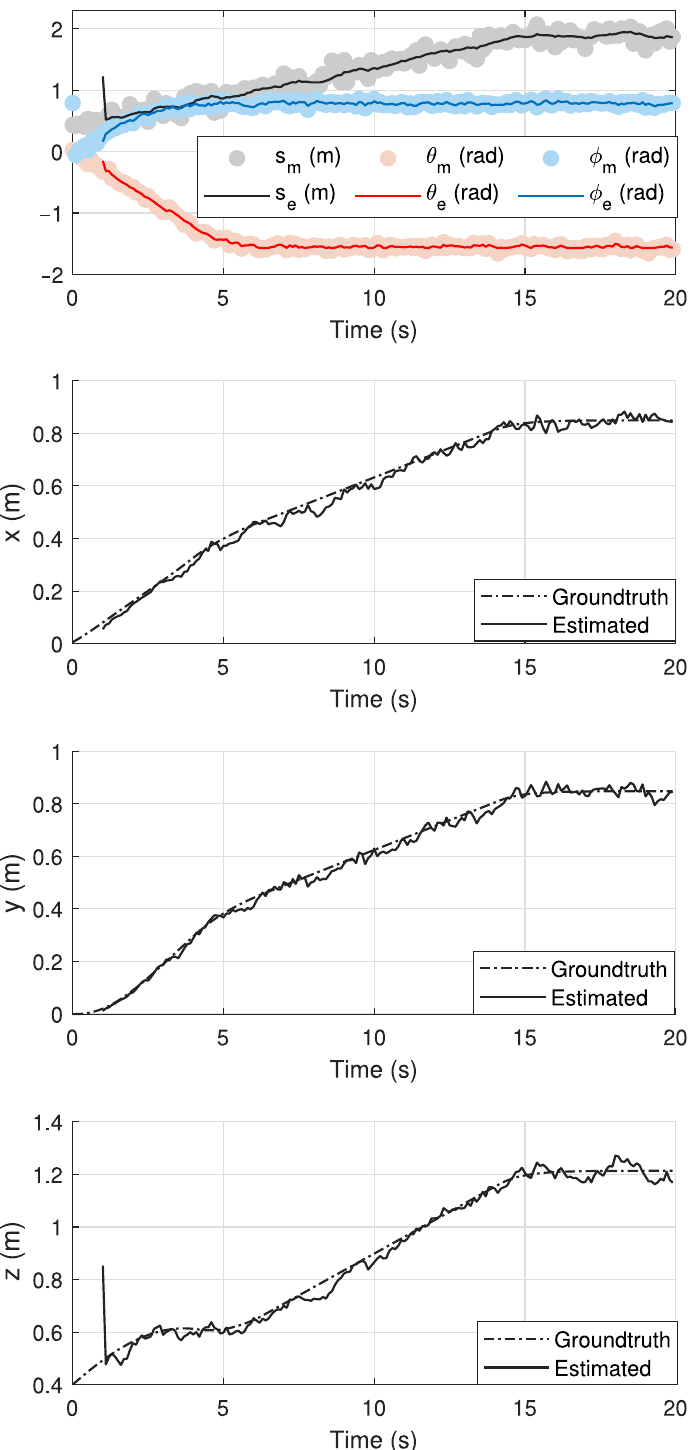
Figure 4. Estimation of vine-robot state components x e = [ x e , y y , z e , s e , θ e , φ e ] T from joint-space measurements y m [ s m , θ m , φ m ]